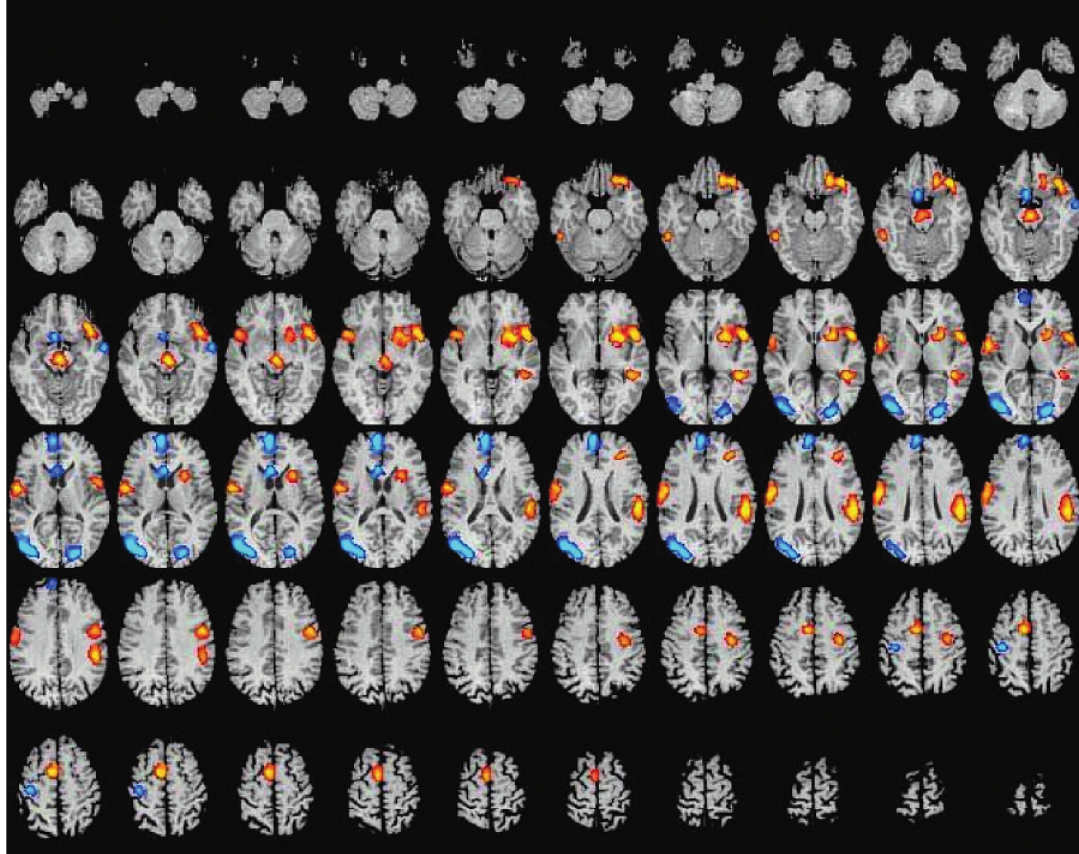
Figure 1 Activation (yellow- red areas) of brain structures assessed by means of func- tional MRI following nasal chemosensory trigeminal stimula- tion (from [15] with permission: Oxford University